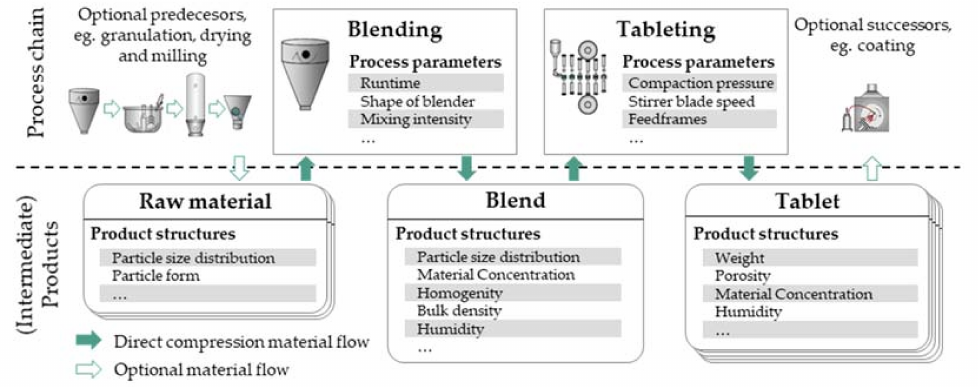
Figure 2. Direct compression process chain with exemplary (intermediate) product